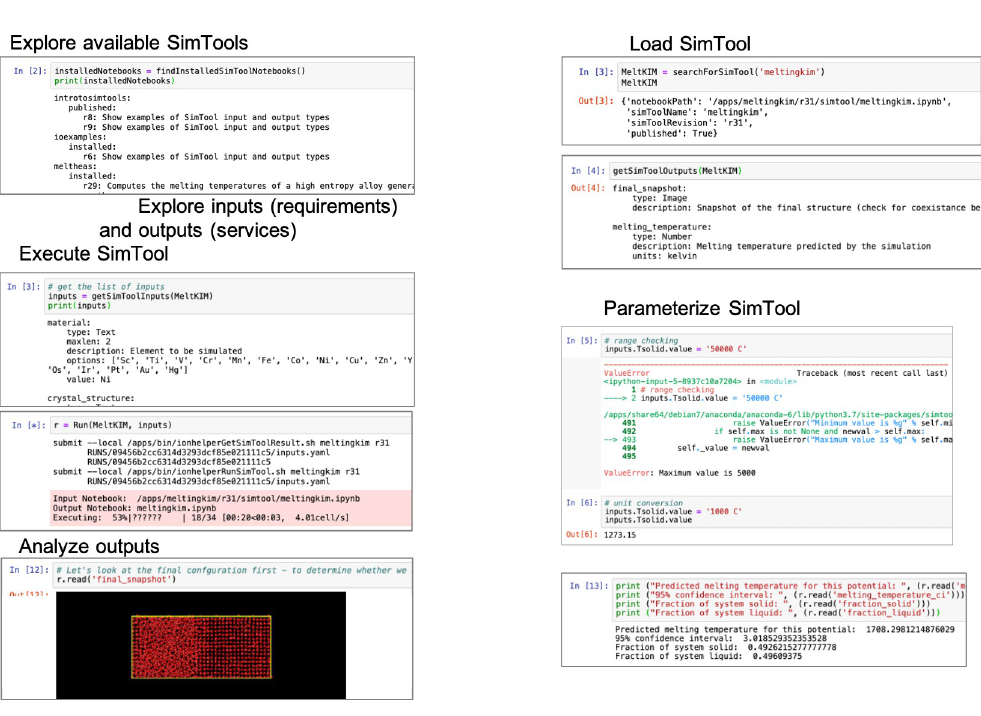
Fig 3. Discovering, parameterizing, executing, and analyzing Sim2Ls